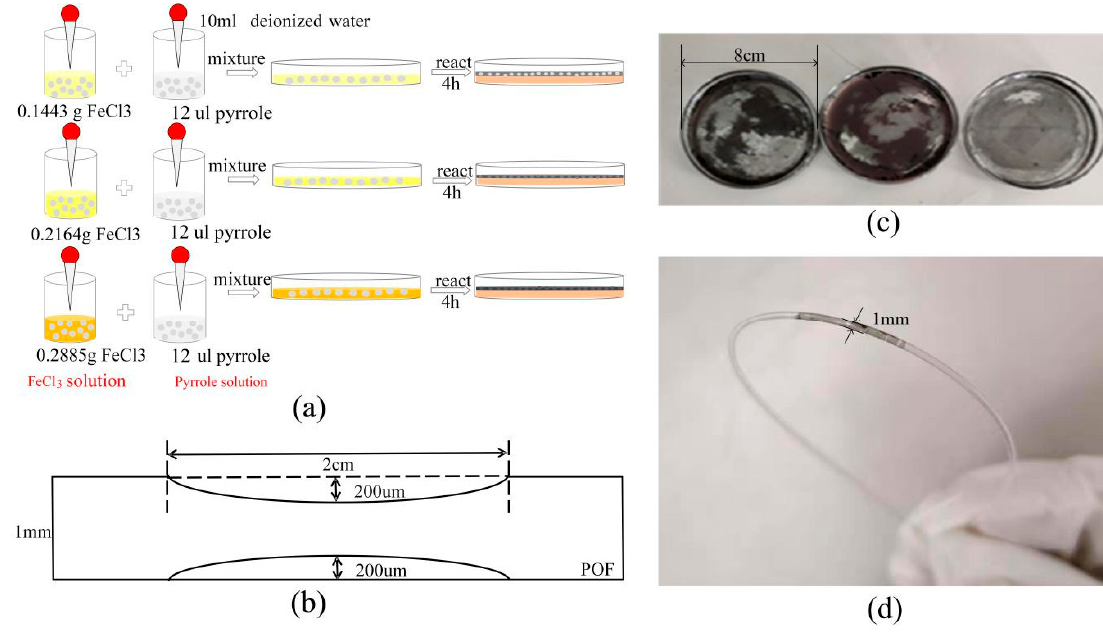
Figure 2. ( a ) The schematic diagram of the preparation of the polypyrrole (PPy) films. ( b ) Parameters of the roughened plastic optical fiber (POF) taper. ( c ) The PPy films at different FeCl 3 to pyrrole ratios; from right to left, nFeCl 3 : n pyrrole = 5:1, 15:2, and 10:1. ( d ) The POF-PPy1 sensor probe.